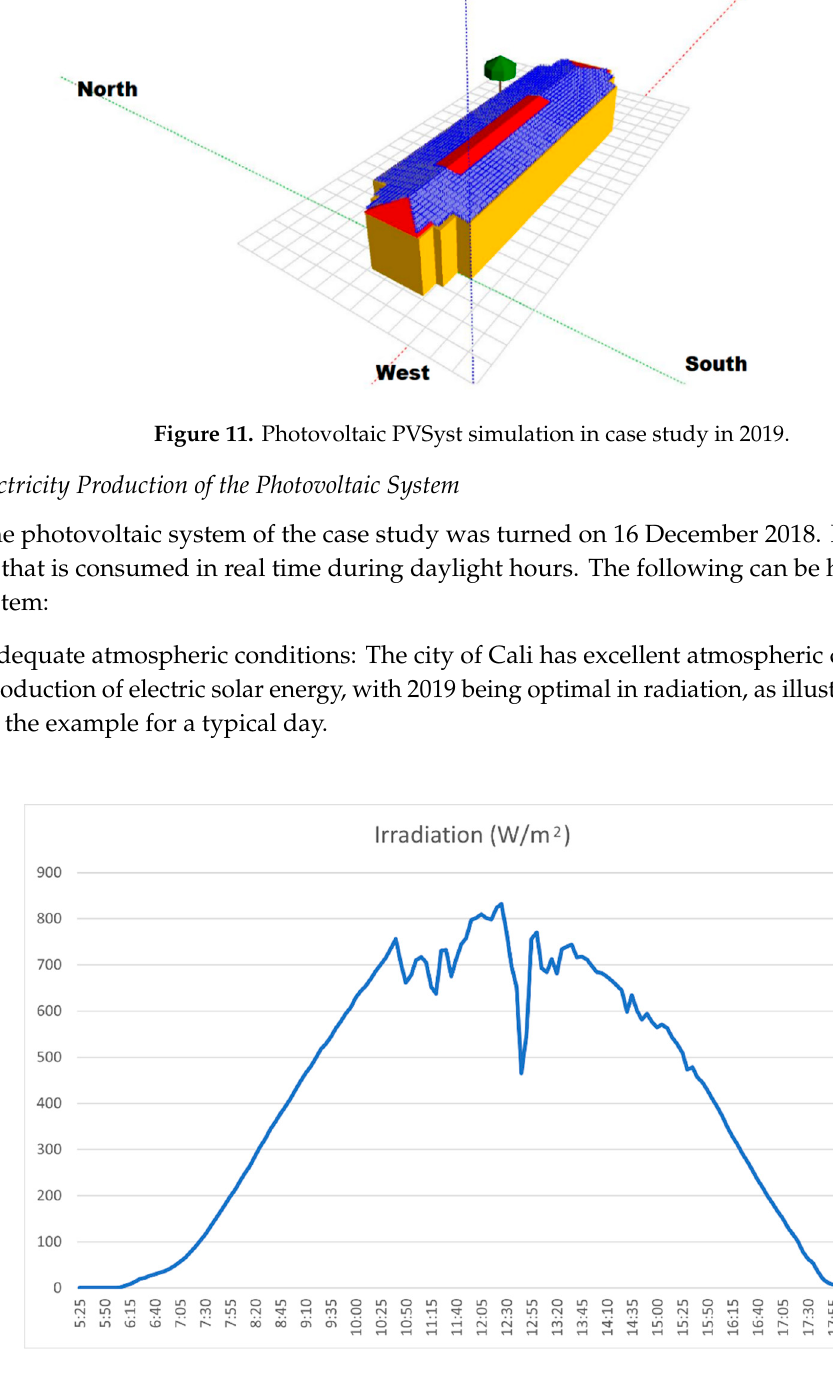
Figure 13. Temperature in the solar panels of the case study for day 27 August 2019.